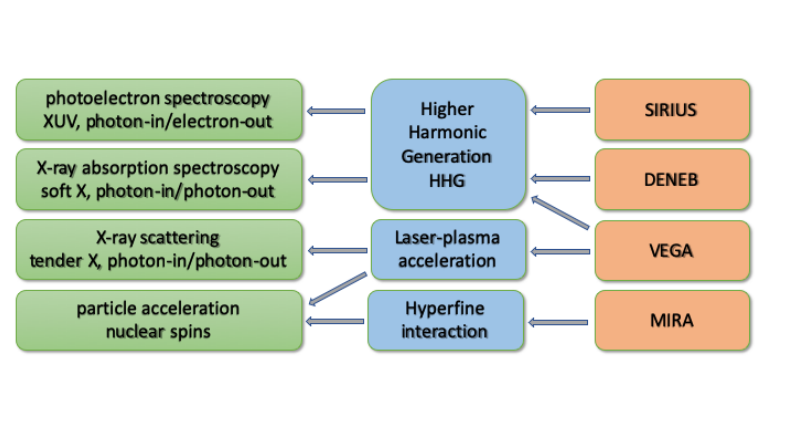
Figure 3: Assigment of the Ju SPARC laser systems (orange) to photon/spin conversion mechanisms (blue) and physics applications